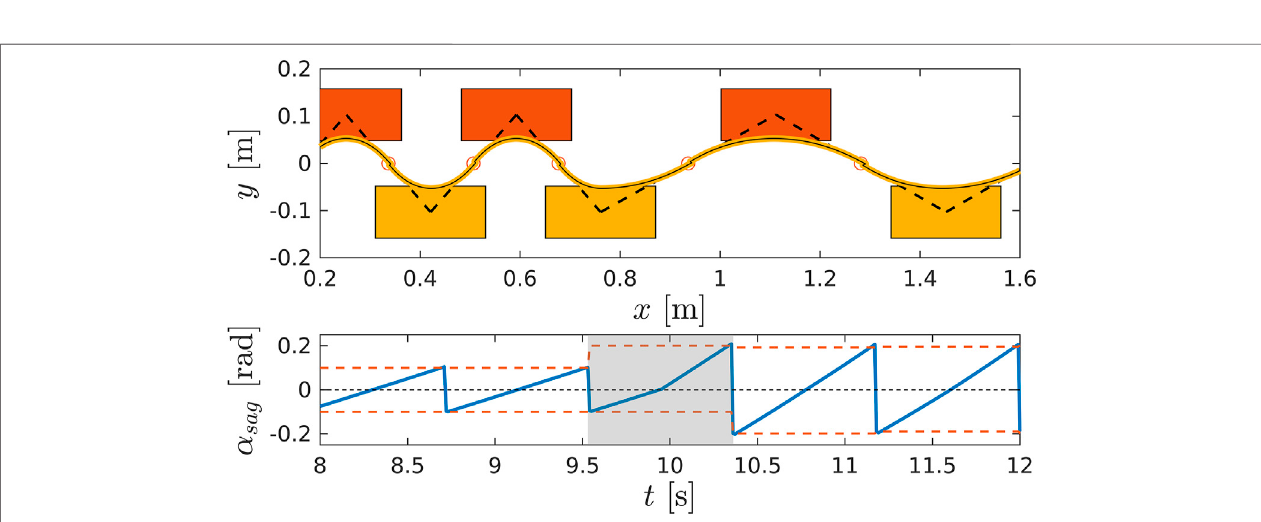
FIGURE 6 | A detail of the WPG changing step stride. Top: walking pattern of the robot changing the length of the step accordingly to the new α max sag . Bottom: the trajectory of the phase variable α sag . The grey area corresponds to the step where α max sag changes: in the second half of the step the steepness of α sag increases, which corresponds to an increase in the CoM